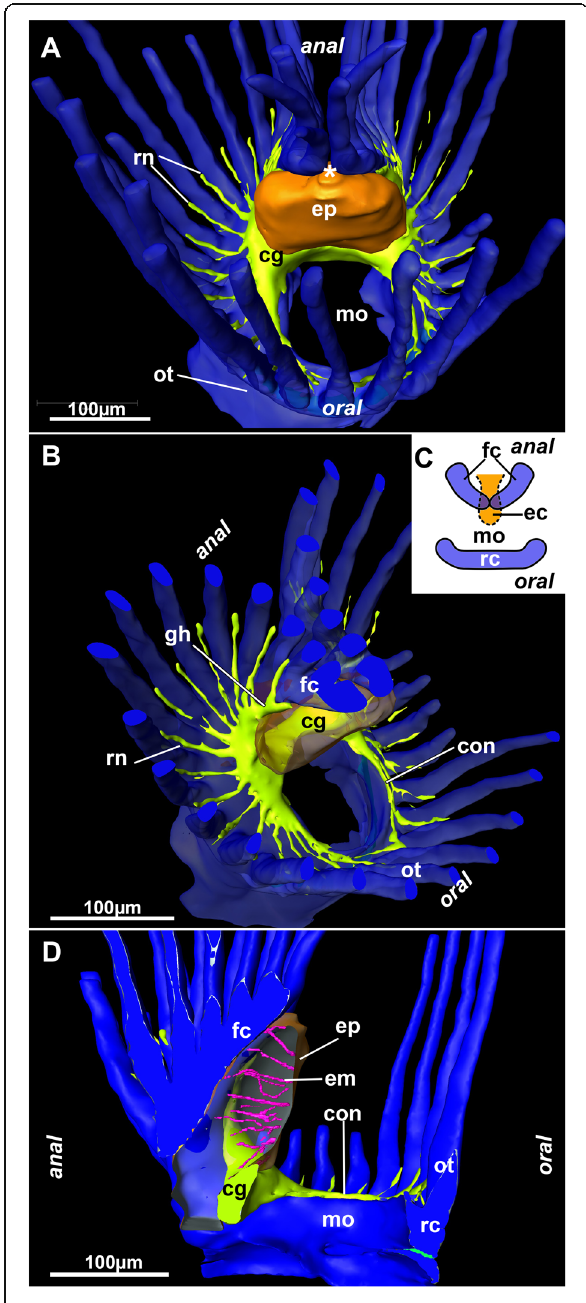
Fig. 5 3D reconstruction of serial semithin sections of the lophophoral base of Stephanella hina . Nervous system in yellow, epistome in orange and coelomic cavity in blue . a Oral view of the lophophoral base showing the epistome above the cerebral ganglion. Note that the inner lophophoral arc (forked canals) is not fused (asterisk). b Oblique view of the lophophoral base with the epistome displayed transparently. c Schematic drawing of the three coelomic canals, the forked canal and the epistome canal on the anal side and the ring canal on the oral side. d Lateral view of the epistome including the muscles traversing its cavity. Abbreviations: cg - cerebral ganglion, con - circumoral nerve ring, ec –